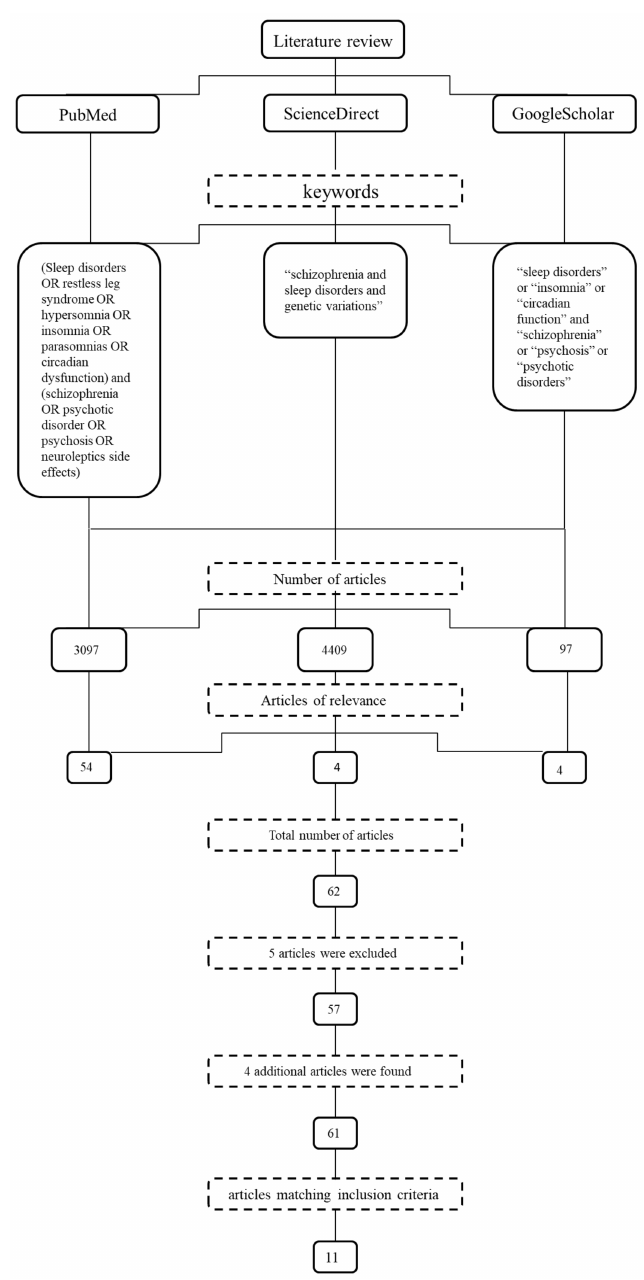
Figure 1. Process of articles